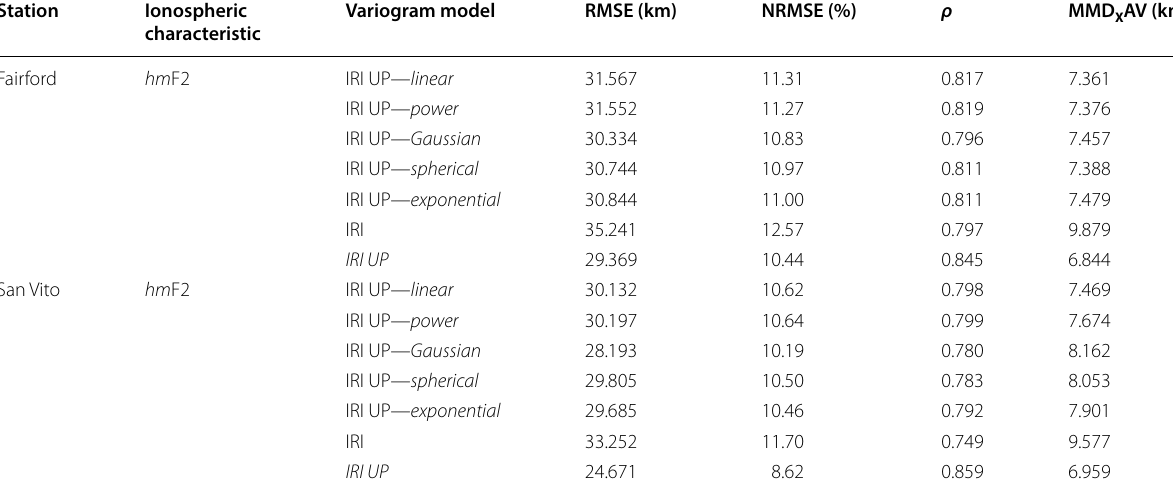
Table 5 Statistical validation of hm F2 characteristic as modeled by IRI UP and IRI